Question: What form of chart is displayed?
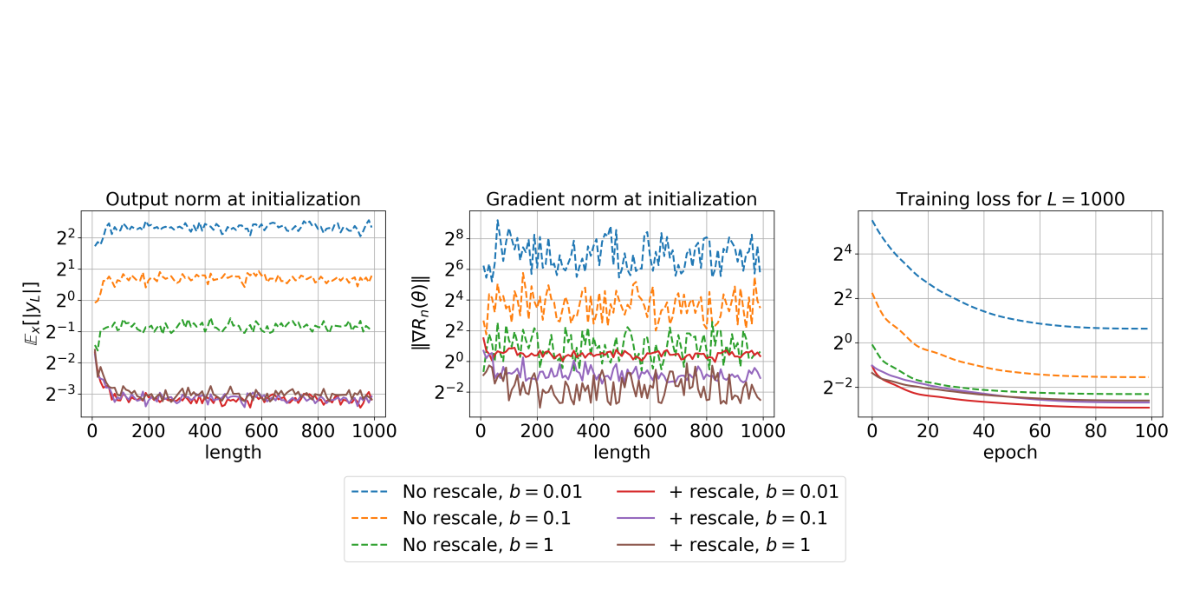
Answer: line